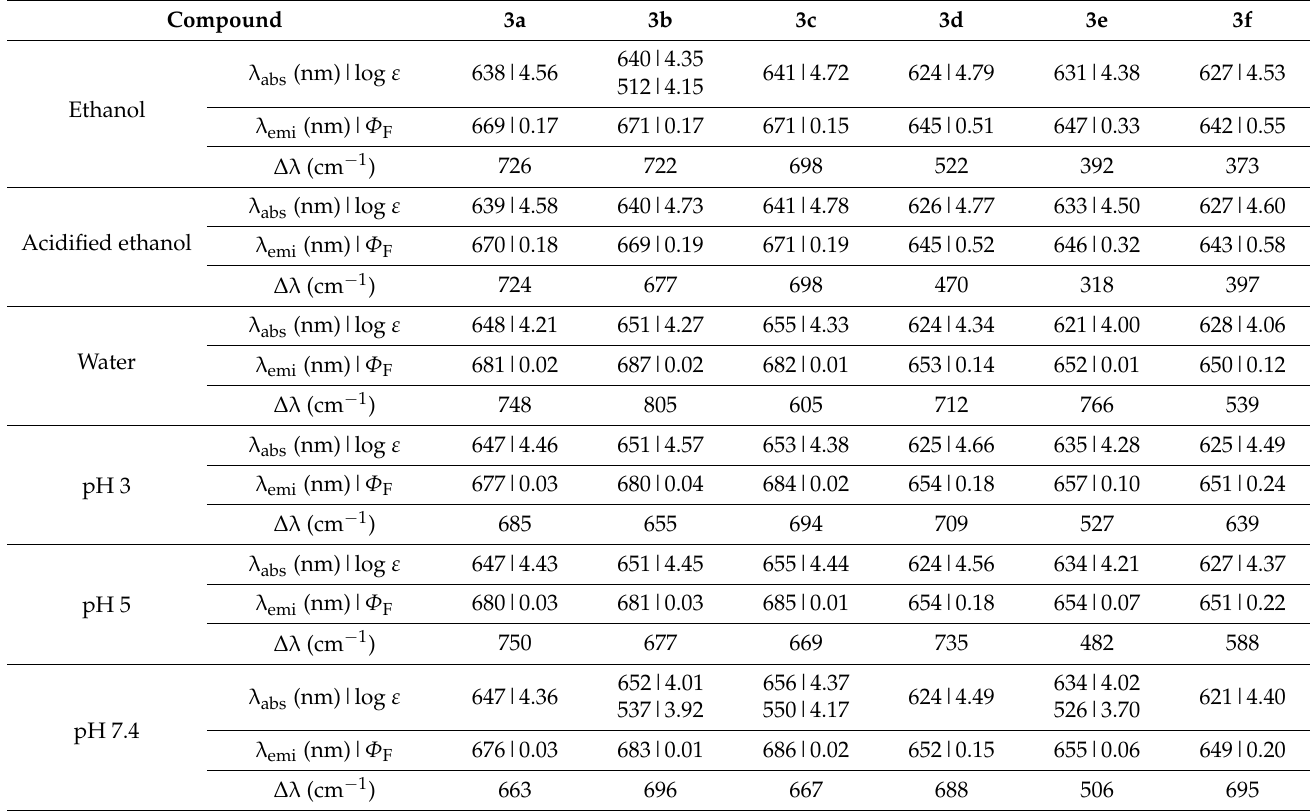
Table 1. Photophysical data for benzo[ a ]phenoxazinium chlorides 3a – f .